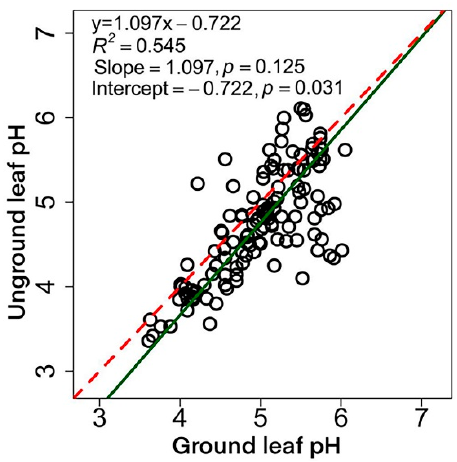
Figure 2. Relationship between two leaf pH measuring methods. The red dash line denotes the 1:1 line, the p value in brackets indicates the difference between the SMA regression slope (intercept) and 1 (0). Fresh leaf samples were used to obtain the unground leaf pH, while the ground leaf pH using oven-dried ones. See Materials and Methods for